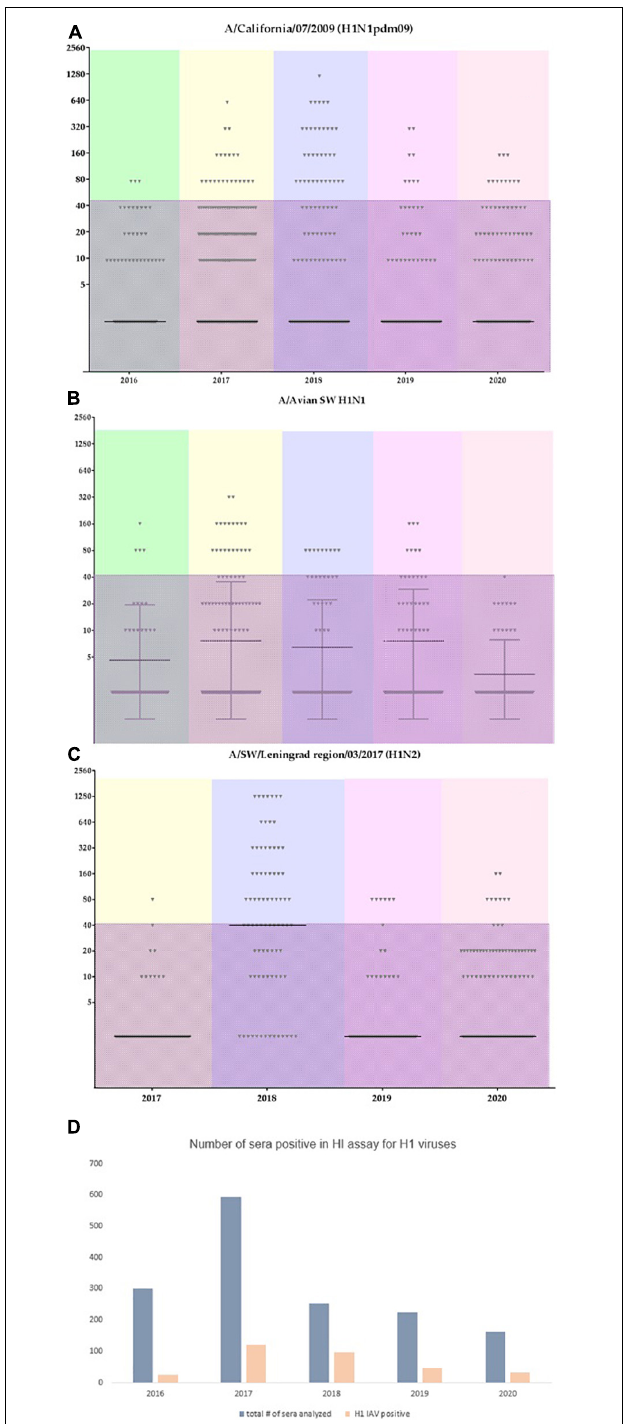
FIGURE 7 | Individual serum titers from swine tested for the most abundant influenza A viruses. Color coding reflects different years. The shaded area marks titers with values of 40 or less. (A) individual titers to A/California/07/2009; (B) individual titers to A/swine/England/195852/1992 (H1avN2); (C) individual titers to A/swine/Leningrad region/03/2017 (H1N2); (D) overall number of sera tested within each year and the overall number of sera which tested positive for the influenza A(H1)